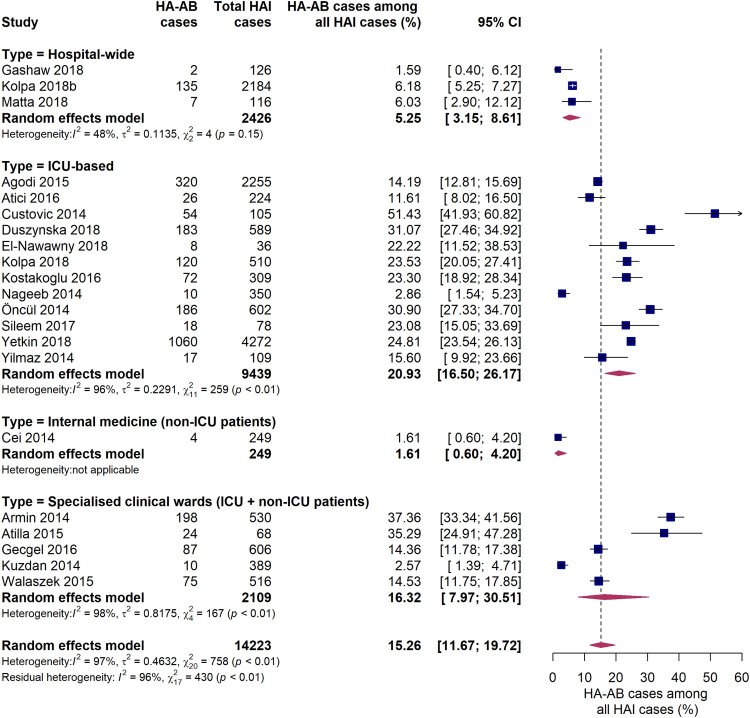
Forest plot of studies on the proportion of hospital-acquired Acinetobacter baumannii infections among all hospital-acquired infections. Abbreviations: HAI: hospital-acquired infections, HA-AB: hospital-acquired Acinetobacter baumannii, ICU: intensive care unit, 95% CI: 95% confidence interval.